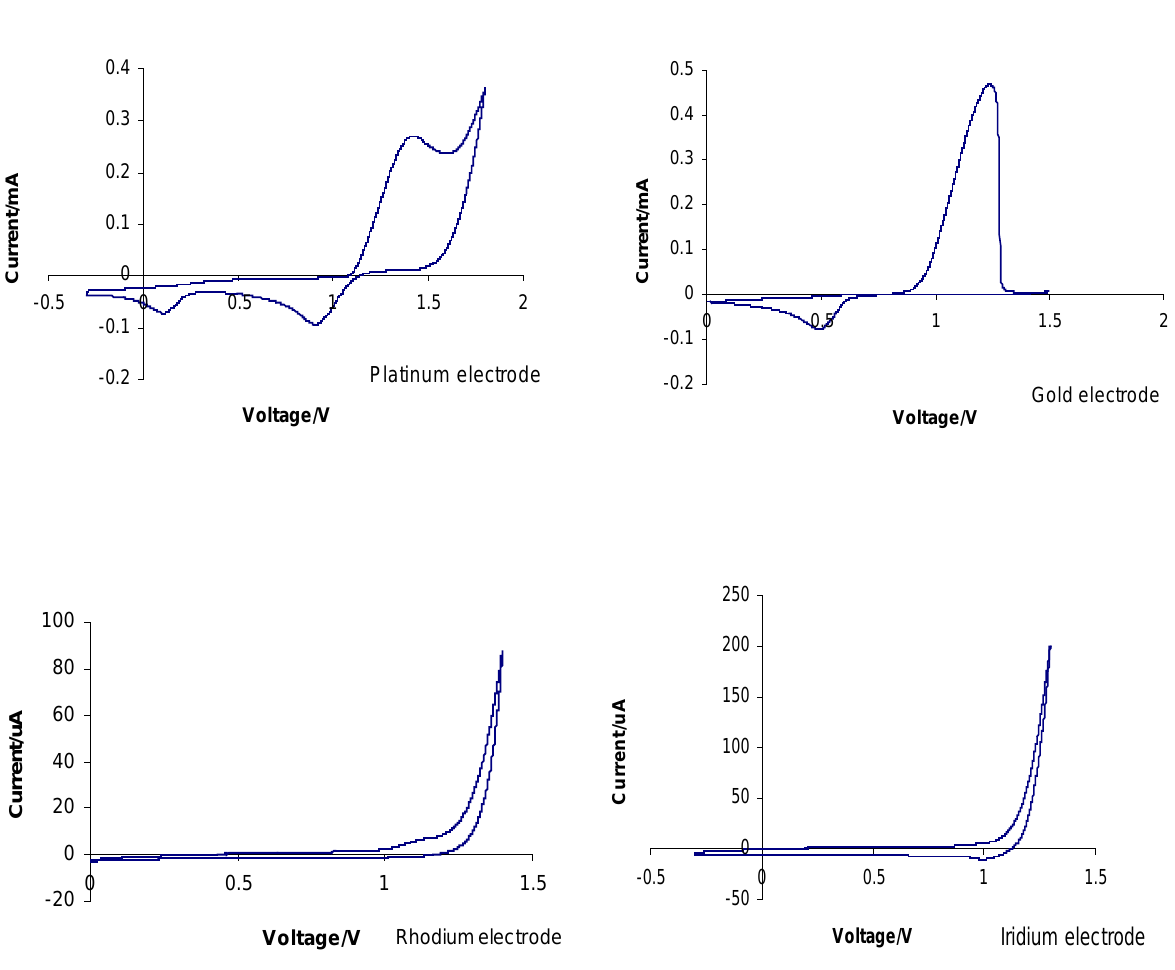
Figure 10. Voltammograms obtained for the working electrodes of the ET sensor in operation in phosphate buffer solution at a pH of 3 and a scan rate of